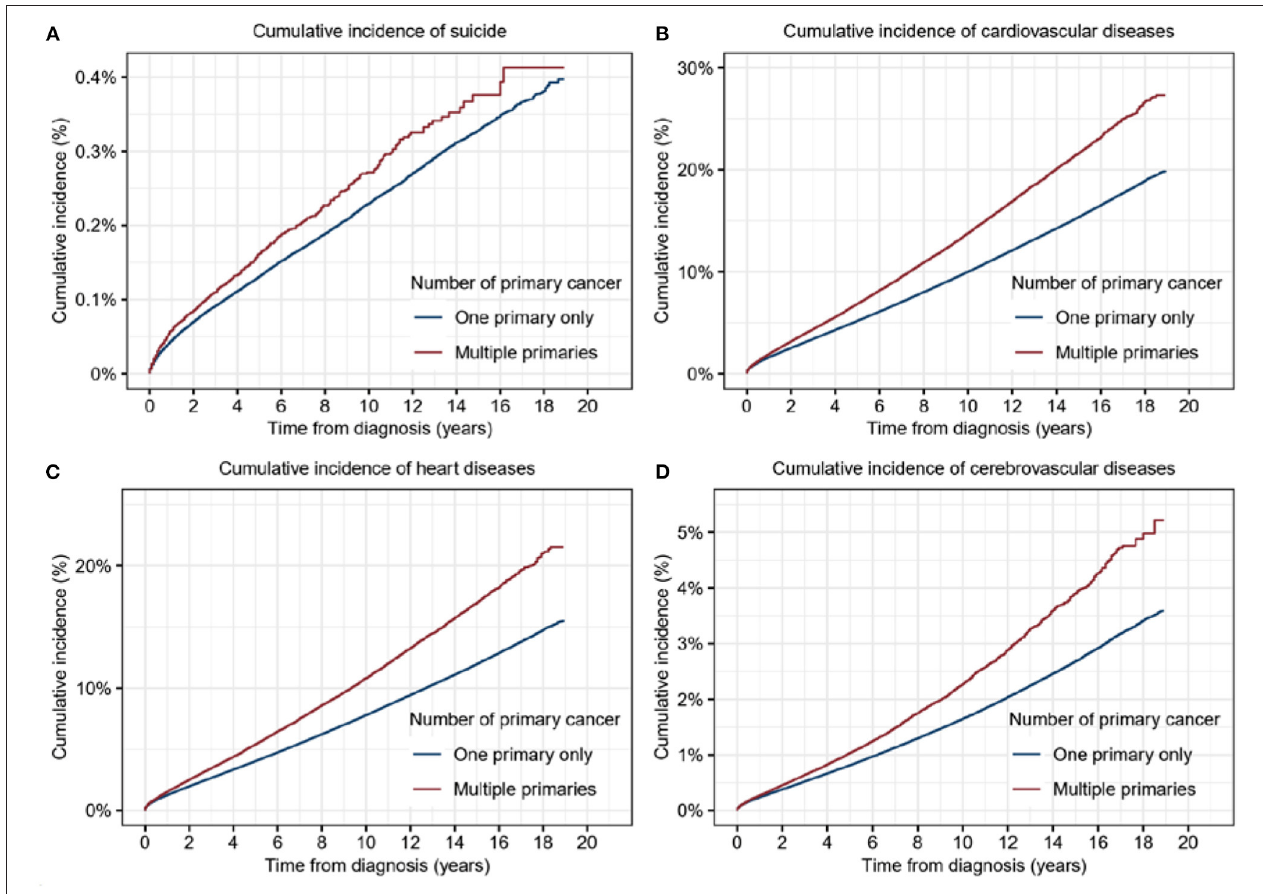
FIGURE 2 | Cumulative incidence of suicide and cardiovascular diseases for patients with multiple primary cancers (MPCs) or single primary cancer (SPC). (A) Cumulative incidence of suicide for patients with MPCs or SPC. (B) Cumulative incidence of cardiovascular diseases for patients with MPCs or SPC. (C) Cumulative incidence of heart diseases for patients with MPCs or SPC. (D) Cumulative incidence of cerebrovascular diseases for patients with MPCs or SPC.